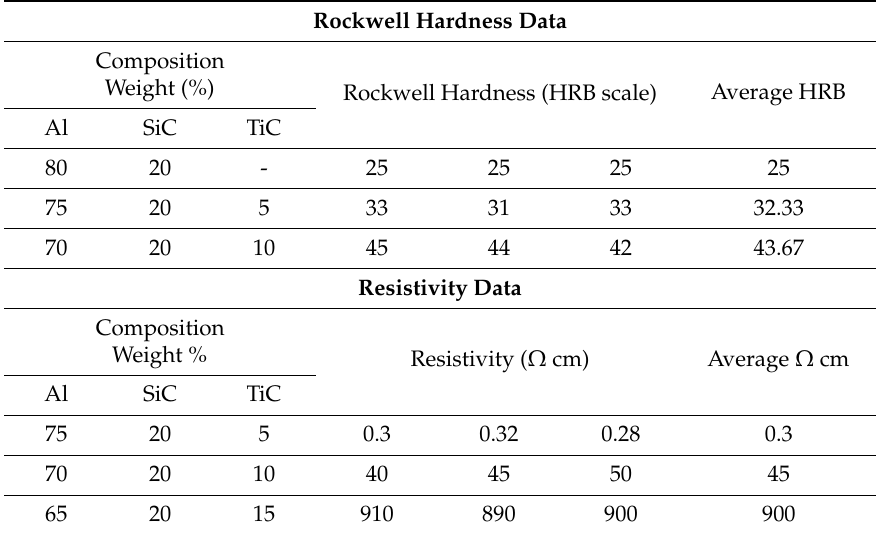
Table 2. Hardness and resistivity data set of the Al-SiC-TiC metal matrix